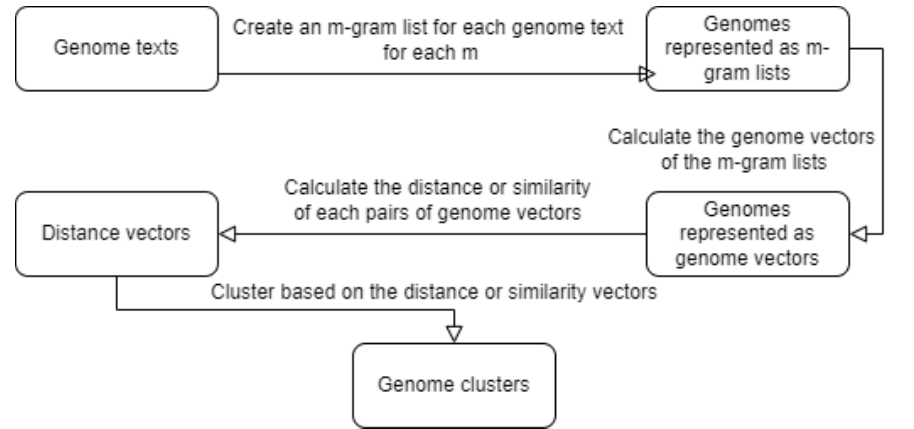
Figure 2. Workflow of the third and fourth